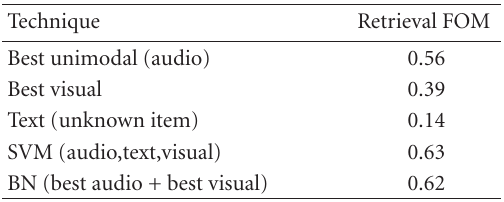
Table 5: FOM results for unimodal retrieval and the two multi- modal fusion